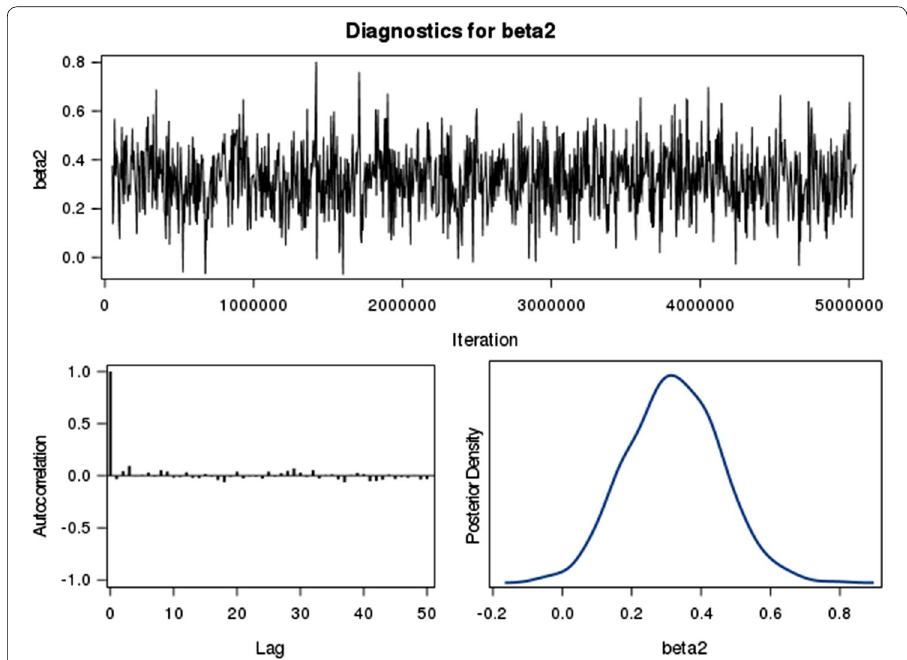
Fig. 4 MCMC diagnostics for β 2 (coefficient of QE _ CON ijk ) in the NAICS 444 (building material and garden